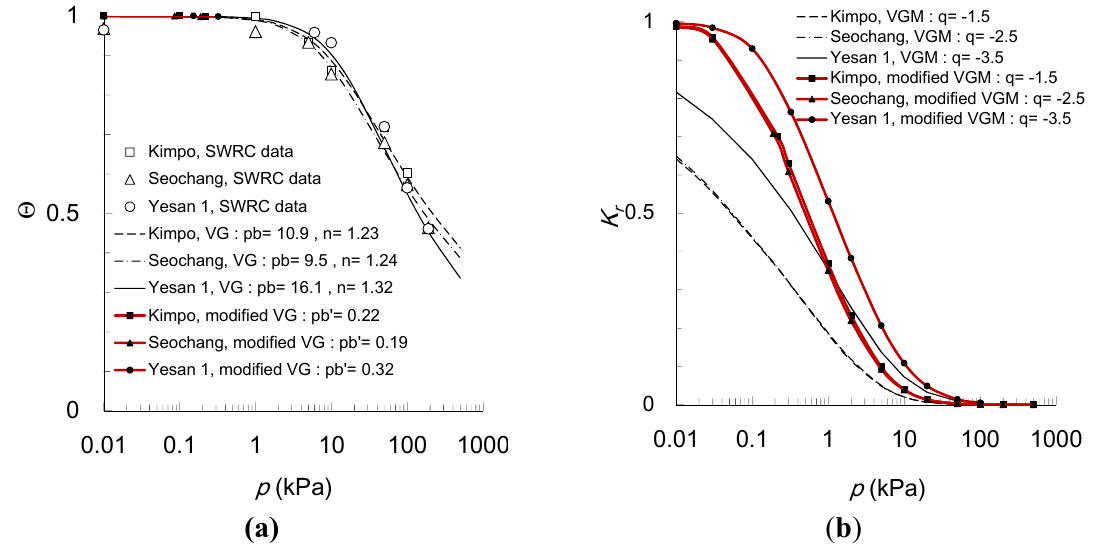
Figure 5. Comparison of the VGM model with the modified model in Group A-1: ( a ) soil water retention curves (the measured data are shown by points, and the modified VG curve by lines with point when p < p b ʹ ); ( b ) hydraulic